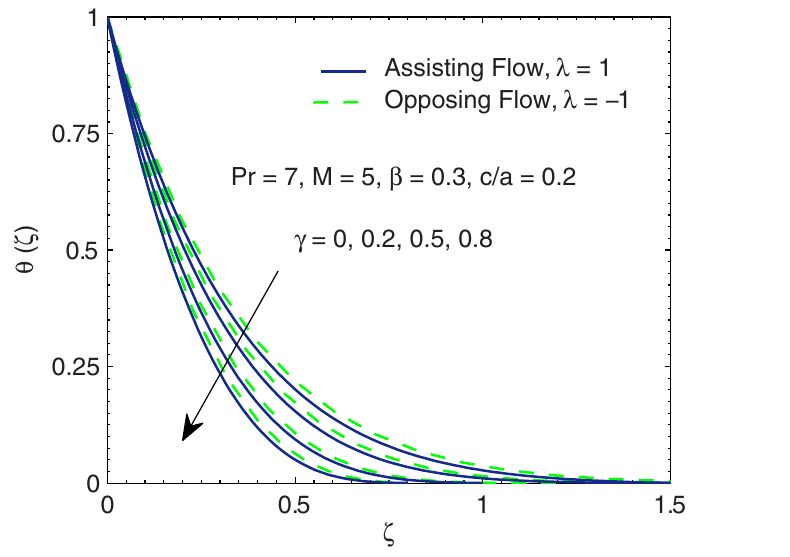
Fig 8. Curves of θ for various values of thermal relaxation time γ